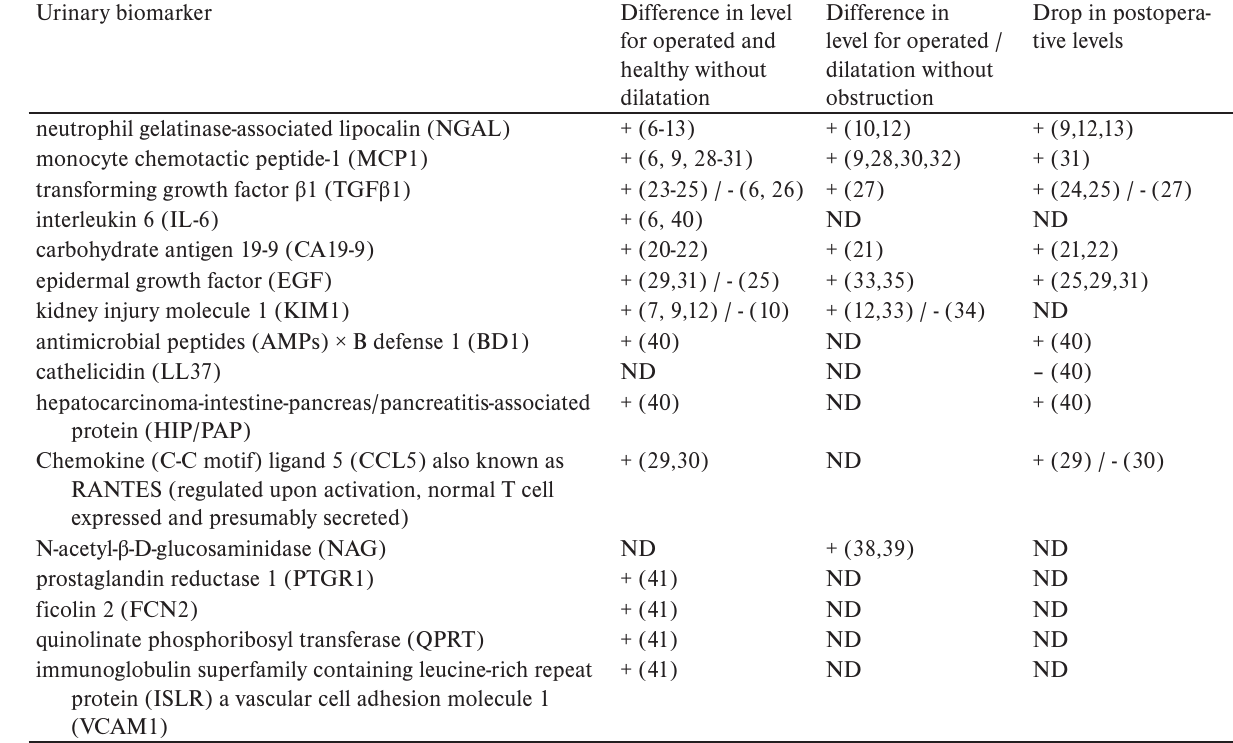
Table 3. Biomarkers and results of clinical